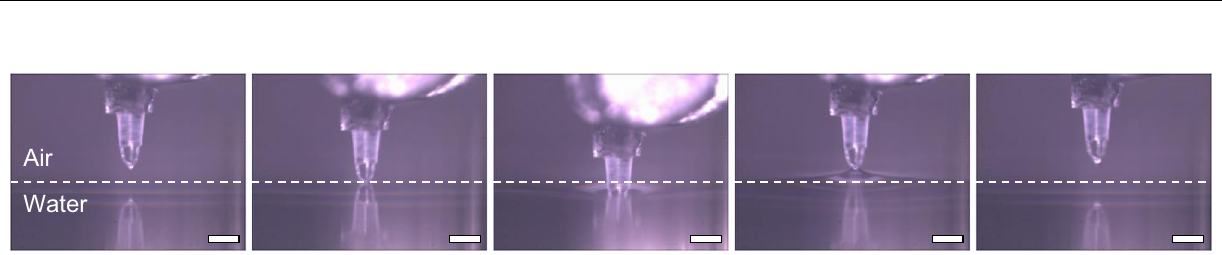
Fig. 6 | Microscopicimages ofa singleclusteredstructure pushing and pulling the water meniscus. Salvinia -like behavior with the water-air interface is shown